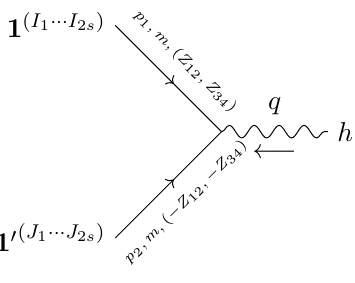
Figure 4 . A 3-pt superamplitude of two massive spin-s multiplets with equal mass m and a massless particle with helicity h